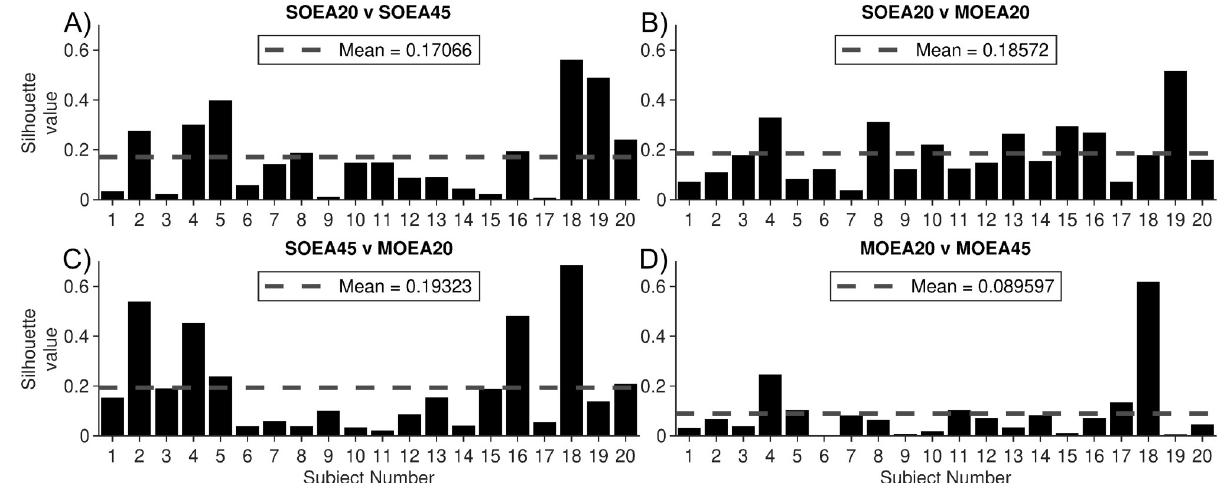
Fig 6. Silhouette scores quantifying differences in parameters recovered from different algorithms. The parameter values are mapped via multi- dimensional scaling to a 2-d space and silhouette scores calculated for pairs of algorithms. A) SOEA20 v SOEA45, B) SOEA20 v MOEA20, C) SOEA45 v MOEA20 and D) MOEA20 v MOEA45 comparisons. In each case, horizontal dashed lines give the mean silhouette score across subjects for the corresponding pairwise comparison.